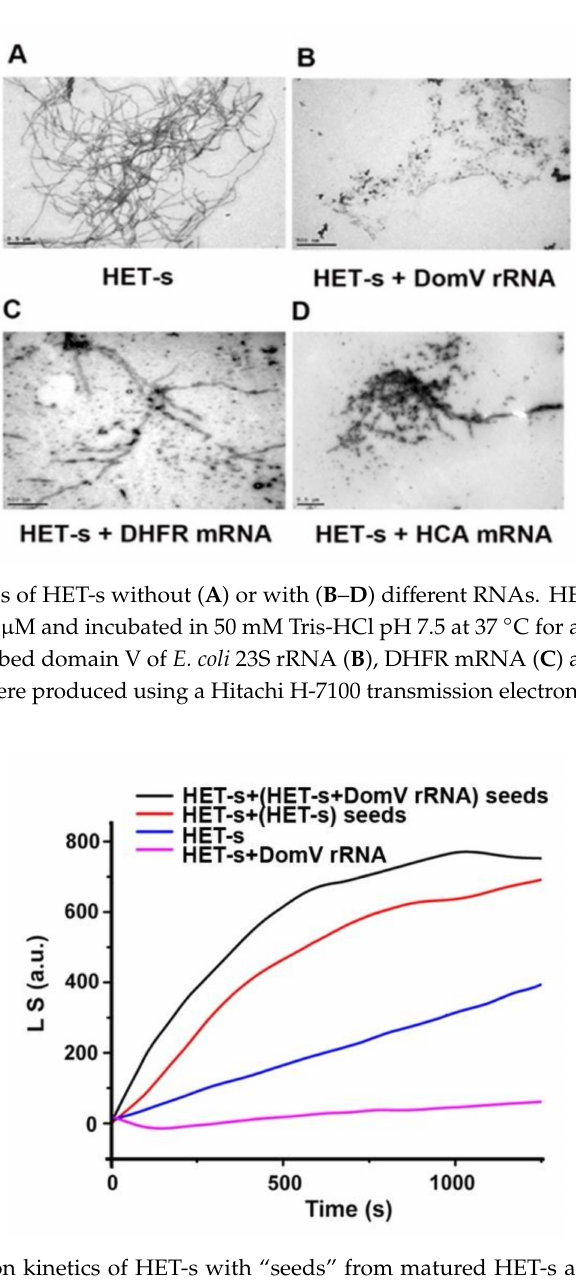
Figure 4. Aggregation kinetics of HET-s with “seeds” from matured HET-s aggregation reactions, conducted with or without domain V of 23S rRNA The aggregation kinetics is followed by Rayleigh light scattering at 402 nm (excitation 400 nm), without (blue trace) or with domain V of 23S rRNA (1 µ M; pink trace) and with “seeds” from previous HET-s aggregation reactions, conducted without or with domain V of 23S rRNA. See Materials and methods for details. The traces in the figure are representative out of three independent